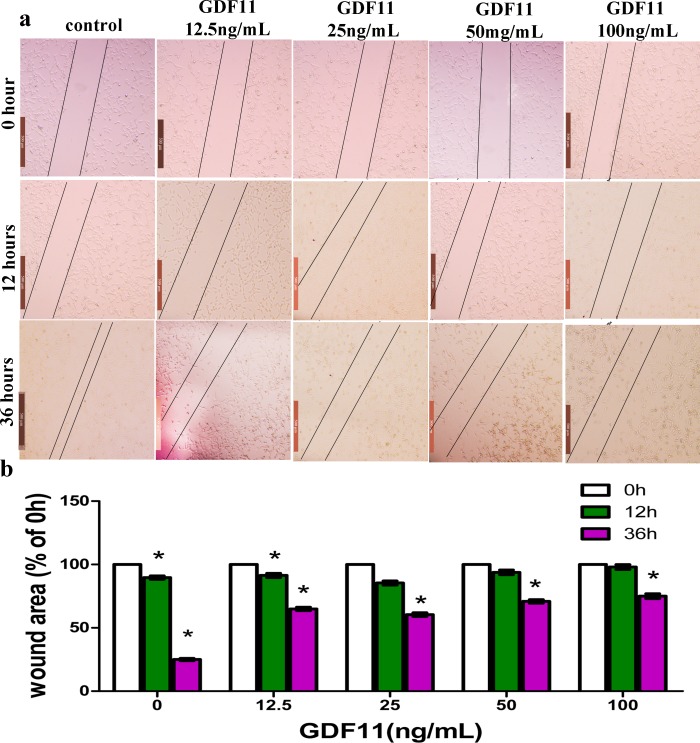
GDF11 inhibited the migration of C17.2 cells.Scratch-wound closure was monitored over time. (A) Representative images showed that GDF11 induced significantly decreased migration speed compared with control (GDF11 untreated cells). Black lines in each graph were pointed toward wound edges. (B) Quantification of the remaining wound area uncovered by migrating C17.2 cells revealed a significant inhibition of migration in GDF11-treated cells. The scratch wound areas at time point 0 hour were set to 100%, and the wound areas at other time point were normalized to their respective 0 hours. Bar is 500 µm (n = 5; *p < 0.05).